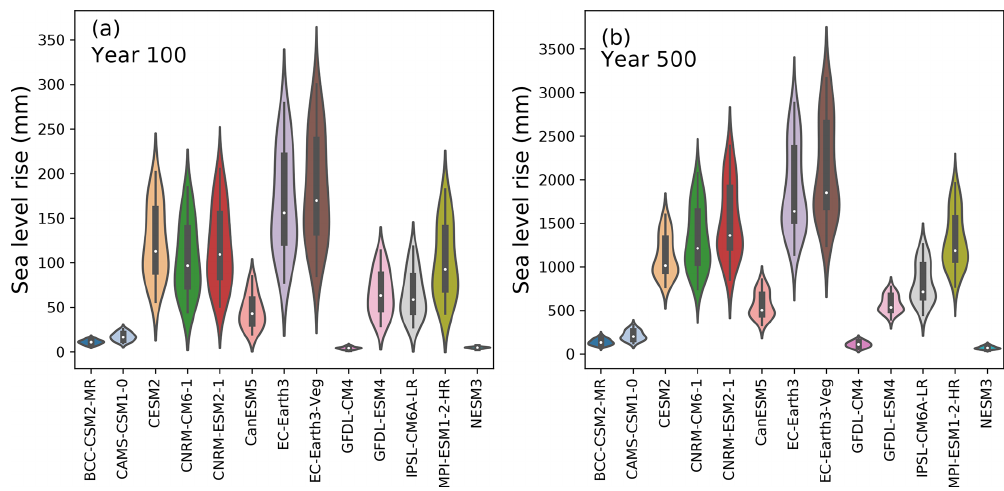
Figure 8. Model spread of SLR after (a) 100 years and (b) 500 years. Note the different y scale in the panels.